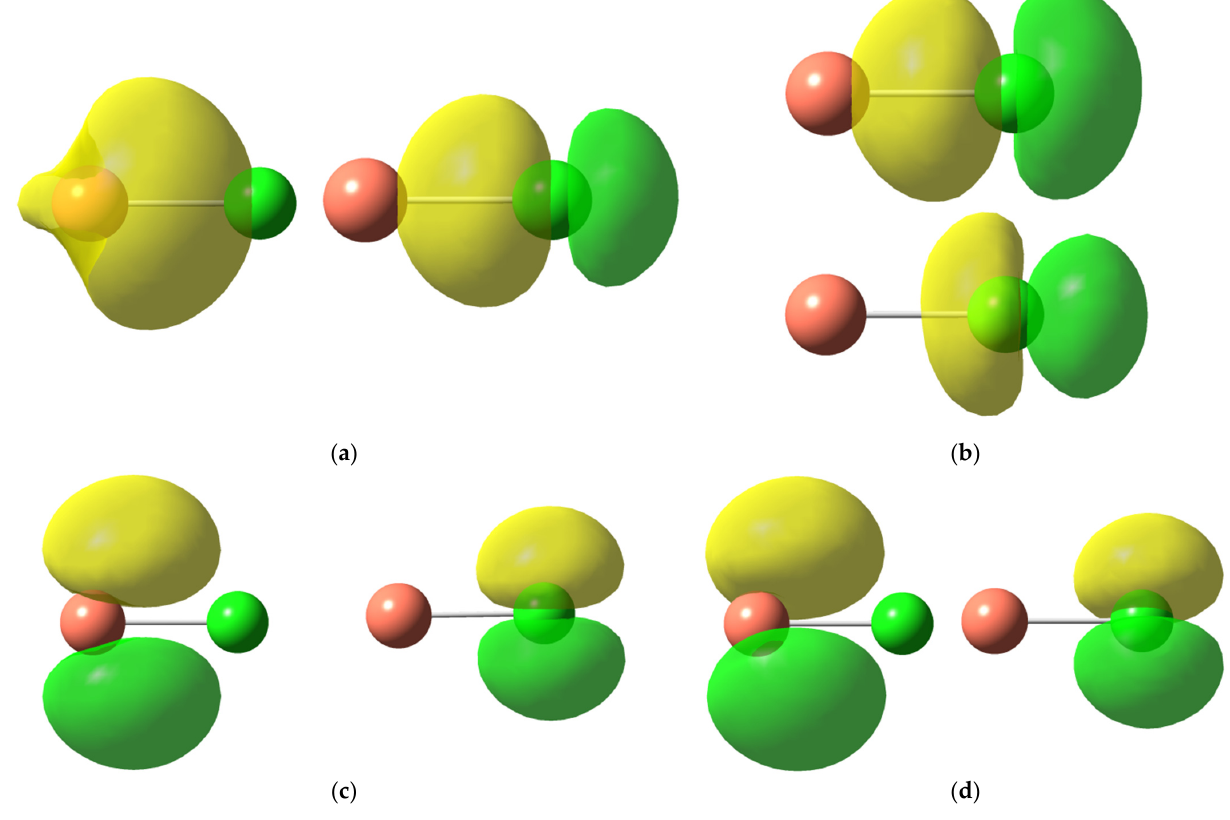
Figure 3. Active orbitals on Cu (left) and Cl (right) involved in the structures 1 ( a ), 2 ( b ), 4 ( c ), and 5 ( d ) obtained at the SD-BOVB/def2-TZVP level (isoval= 0.05). Table 2. Bond dissociation energies (in kcal/mol) obtained at the SD-BOVB and CCSD(T) levels, together with experimental values for reference. The mean absolute errors ( MAE ) are calculated by reference to the corresponding CCSD(T) values in the largest basis set (italic), and for SD-BOVB also with respect to CCSD(T) values in the same basis set (in parenthesis and